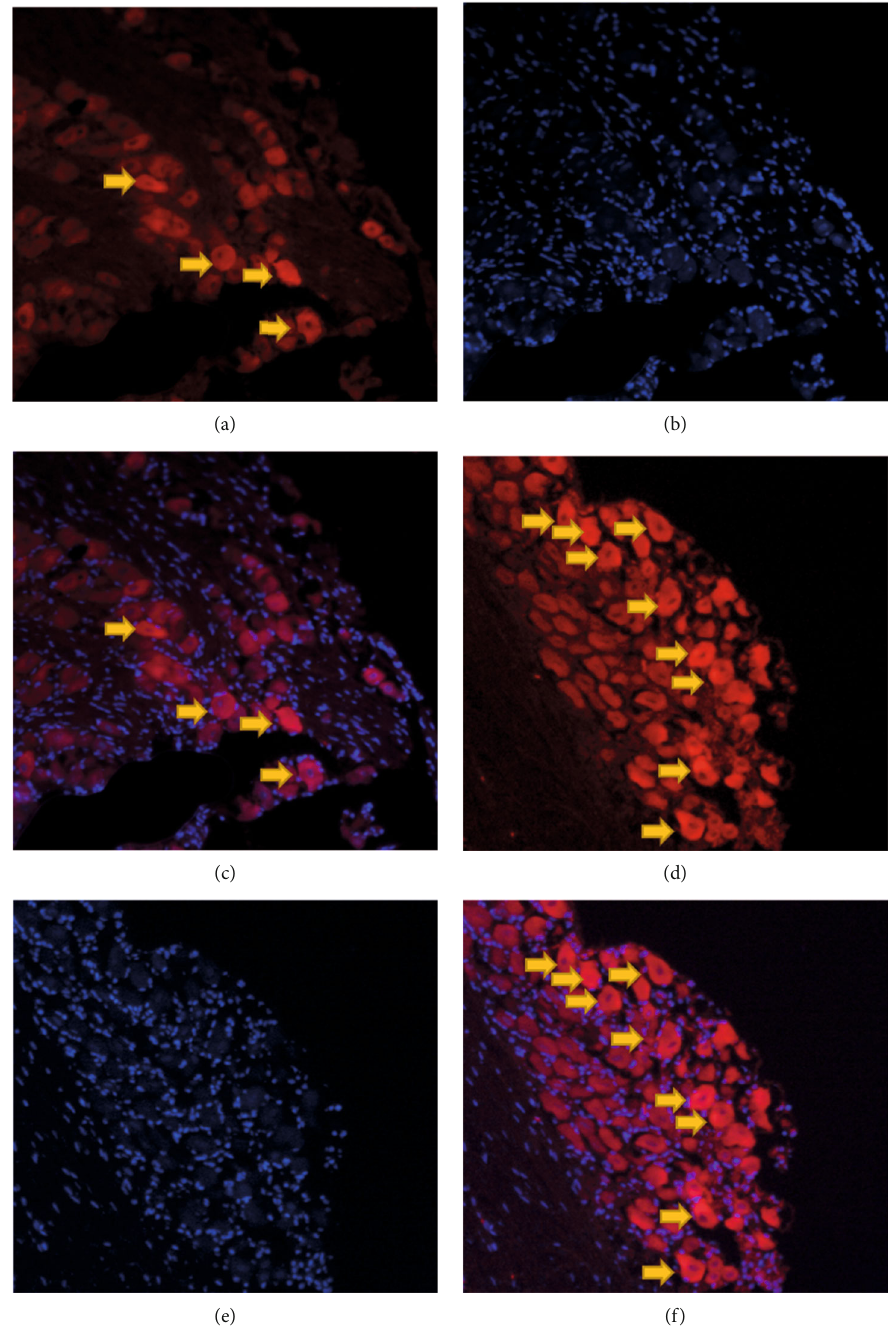
Figure 3: Distribution of PKH26-labeled SHED in the ipsilateral TG: (a) PKH26-positive cells (red) 24 h after local injection; (b) DAPI- stained cells (blue) 24h after local injection; (c) the merged image of (a) and (b); (d) PKH26-positive cells (red) 72h after local injection; (e) DAPI-stained cells (blue) 72h after local injection; (f) the merged image of (d) and